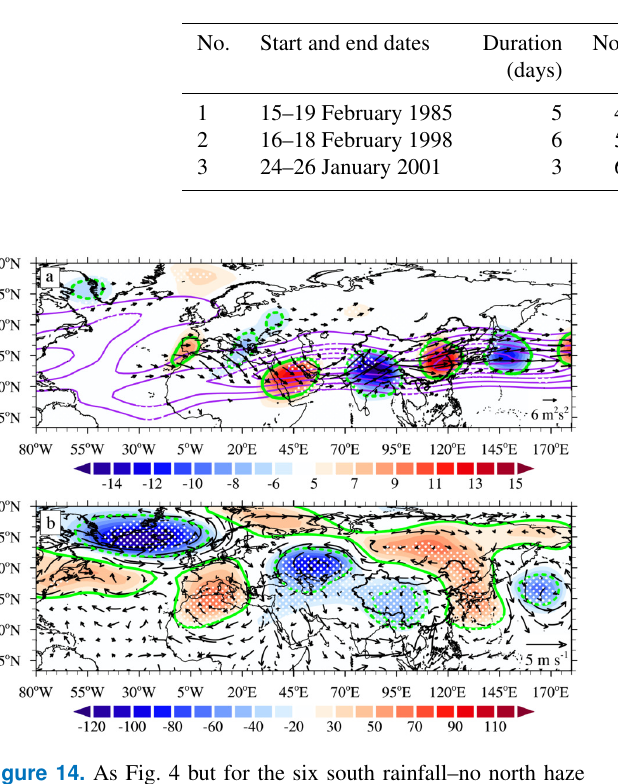
Figure 13. Schematic representation of the impact of heavy rainfall over southern China on haze production over the NCP. Table 2. Start and end dates, and duration, of each SR–noNH event.